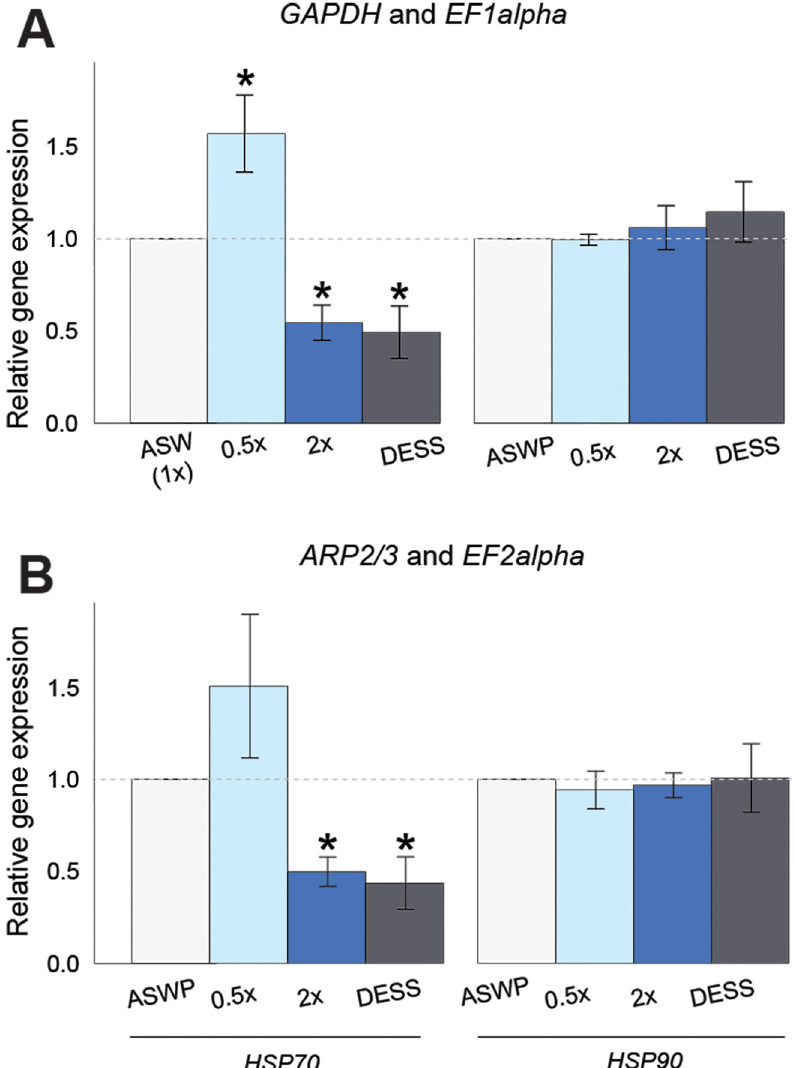
Fig 5. Detection of significant change in gene expression depending on the reference gene choice. Expression of two heat shock protein genes ( Hsp70 and Hsp90 ) normalized by the two most stable (A: EF1A and GAPDH ) and two least stable (B: ARP2/3 and EF2A ) reference gene pairs. Statistically different gene expression from ASWP is indicated by � (Student’s t-test; normal distribution, unequal variance; p <